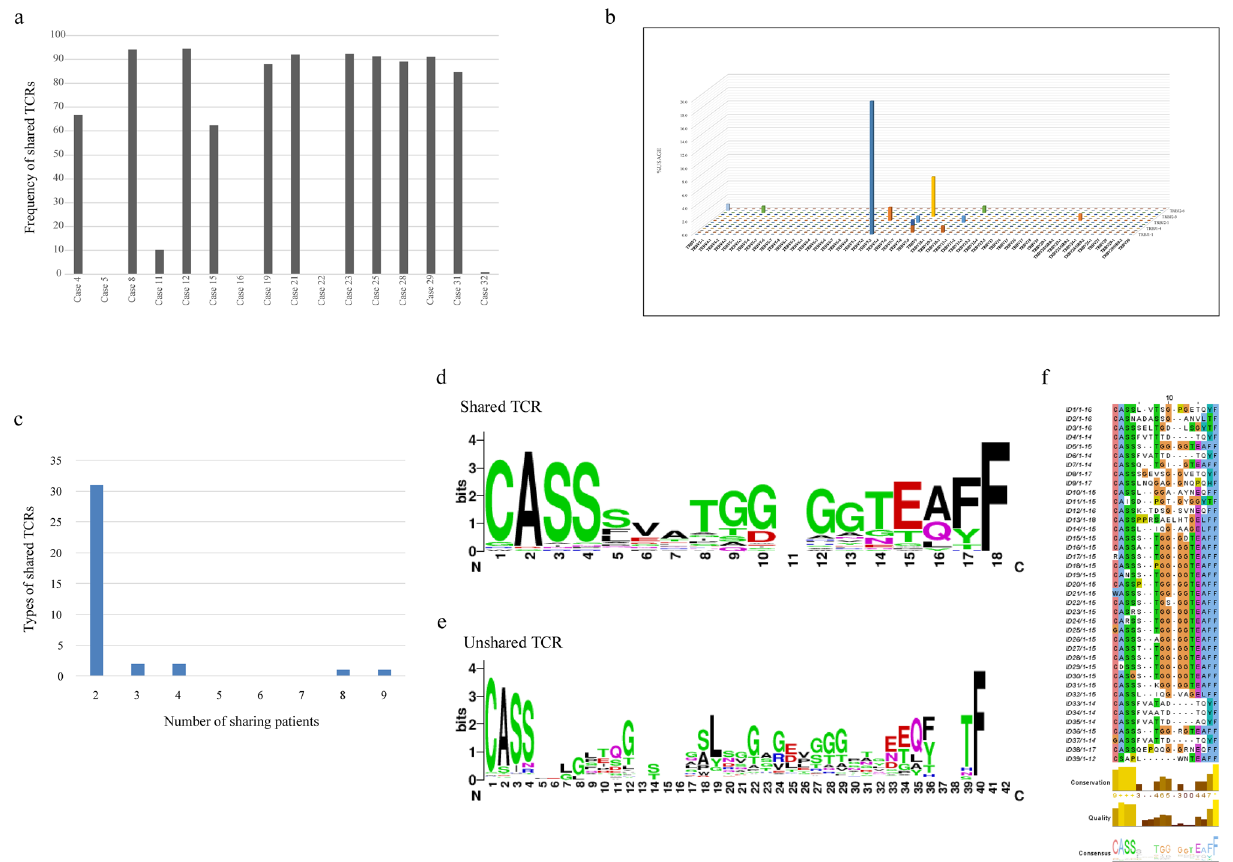
Figure 4. Characteristics of shared T-cell receptors (TCRs) of cytomegalovirus-specific cytotoxic T-cells. ( a ) Frequency of shared TCRs among CMV-CTLs in each patient. ( b ) TRBV and TRBJ usage of shared TCRs. The X and Y axes indicate TRBV and TRBJ segments, respectively, and the Z axis indicates the number of shared TCR types. ( c ) The number of TCRs and number of different patients that share each sequence. ( d , e ) Representation of multiple sequence alignments for complementarity determining region 3 (CDR3) in ( d ) shared and ( e ) unique TCRs. The relative size of the amino acid letters in the logo diagram represents the frequency of representation for each amino acid. ( f ) List of amino acid sequences in CDR3 for shared